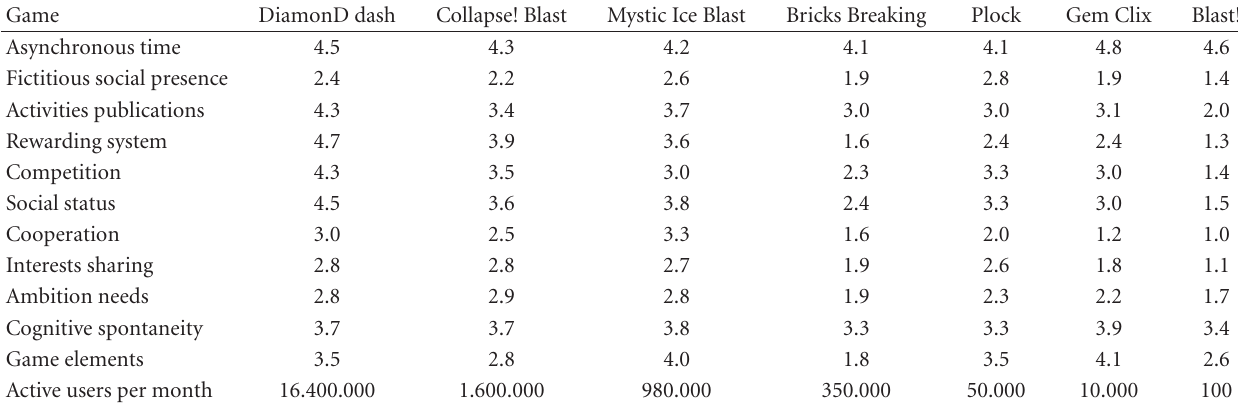
Table 2: Level of presence of the motivational elements at the Match 3-type